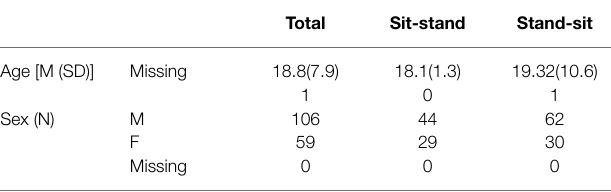
TABLE 1 | Participants’ characteristics ( N = 165) total and per order of condition. Total Sit-stand